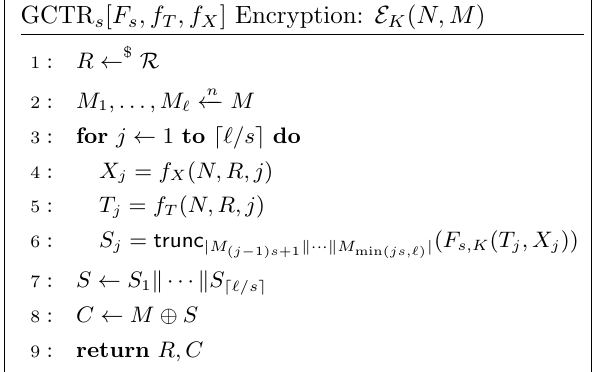
Figure 2: Encryption algorithm of the generic CTR mode instantiated with a MFC F s : K × { 0 , 1 } t × { 0 , 1 } n → { 0 , 1 } sn . Different definitions of the functions f X and f T yield concrete variants of the GCTR (see Table